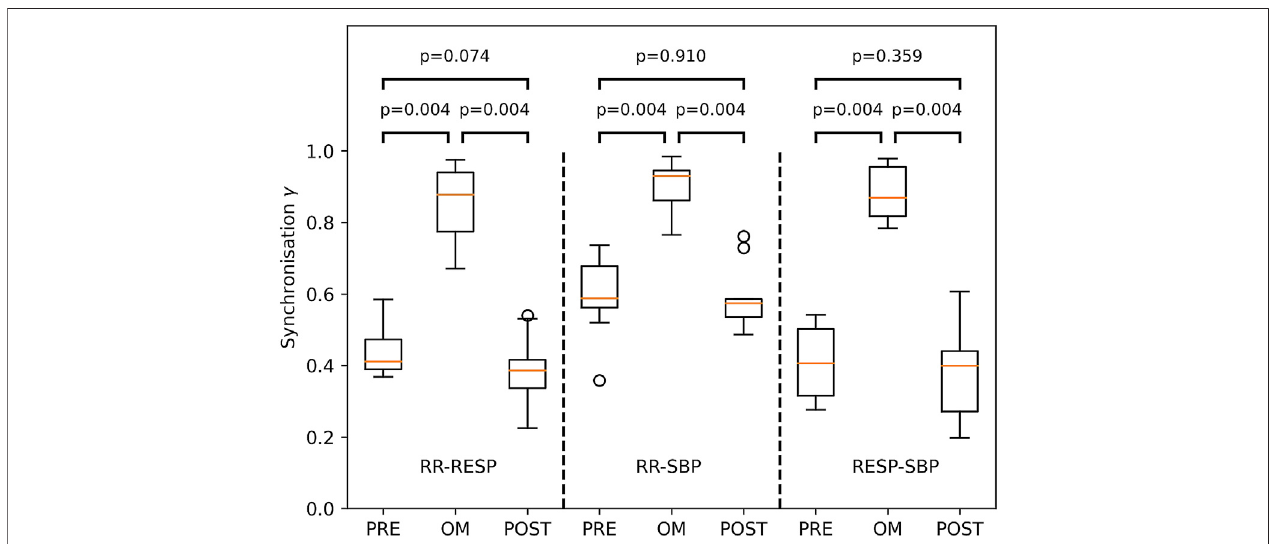
FIGURE 5 | Boxplots of the synchronisation index γ between RESP and RR (left part), RR and SBP (middle part) as well as RESP and SBP (right part) during PRE- resting, OM and POST-resting condition. The probability of similar values between two conditions is indicated by the p-values above the box and whisker plot. The boxplots show median and quartiles (horizontal lines), and maximum and minimum values (whiskers).